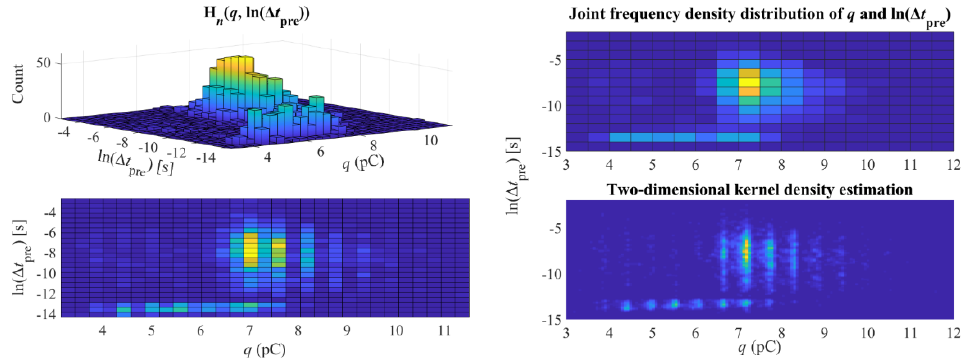
Figure 5. The illustration of H n ( q , ln( Δ t pre )) and the corresponding result of two − dimensional kernel density estimation.